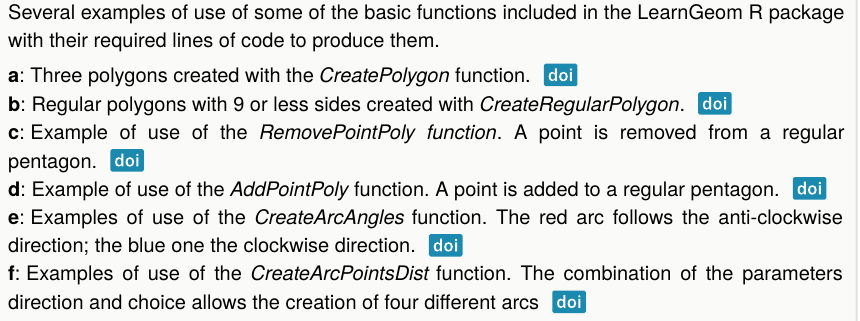
Several examples of use of some of the basic functions included in the LearnGeom R package with their required lines of code to produce